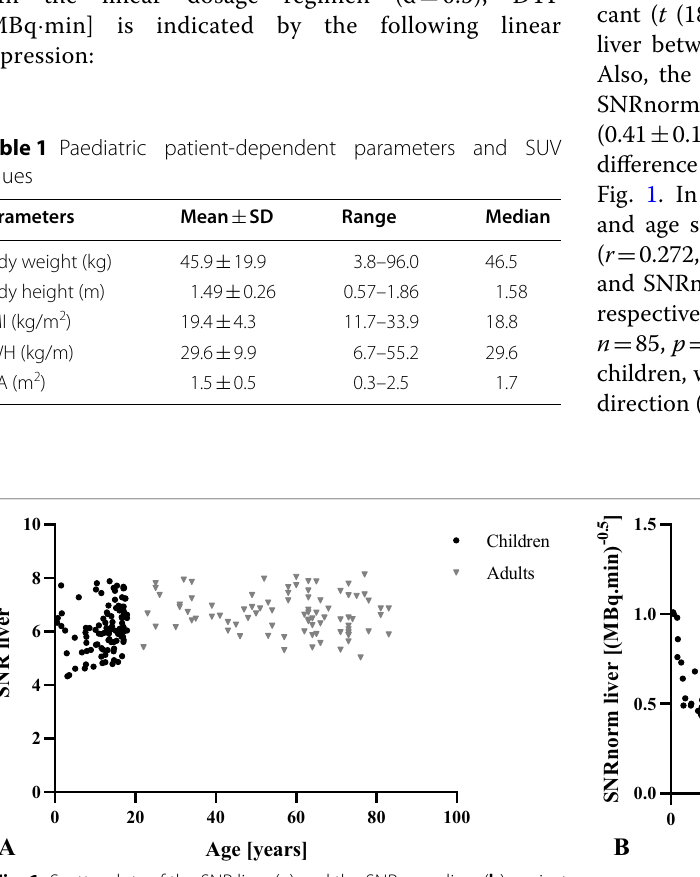
Fig. 1 Scatterplots of the SNR liver ( a ) and the SNRnorm liver ( b ) against